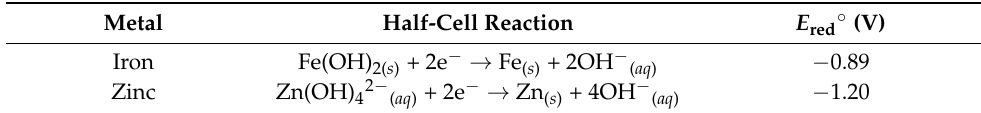
Table 1. Possible anode materials and their half-cell